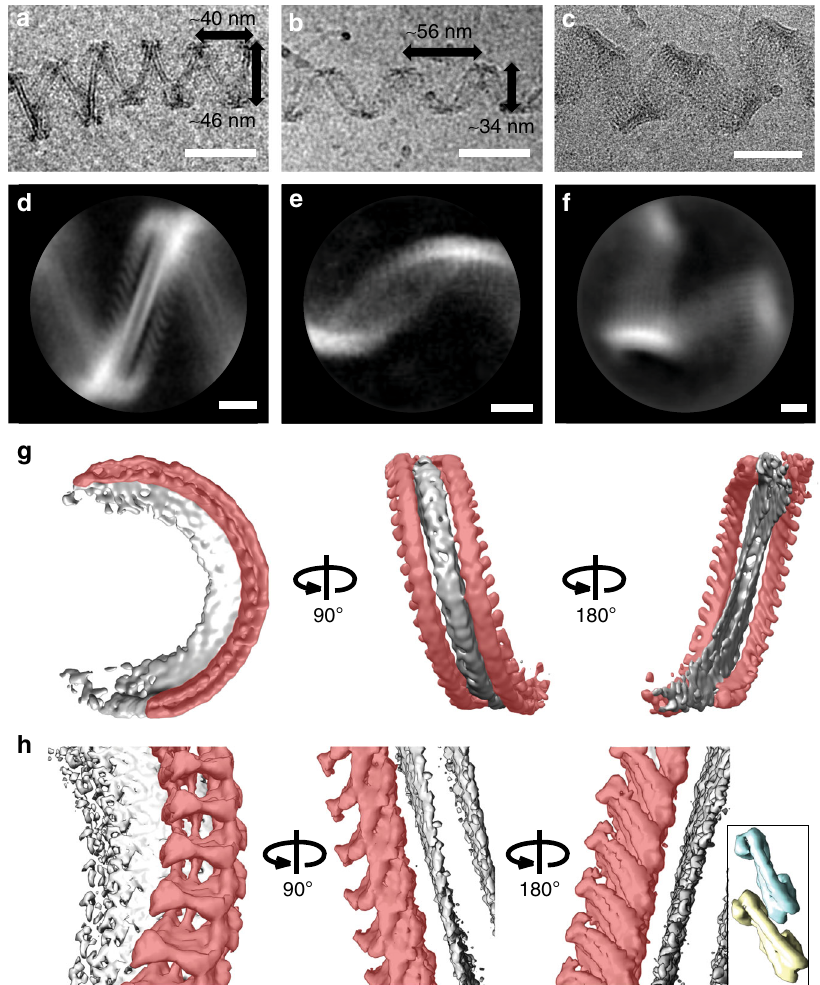
Fig. 3 Organization of tube-less ESCRT-III fi laments. Electron micrographs ( a – c , scale bars 50 nm) and 2D class averages ( d – f , scale bars 10 nm) showing different tube-less, helical ESCRT-III fi lament bundles formed from Snf7, Vps24, and Vps2 upon detergent removal. The majority of ribbons adopted a zigzag shape ( a , d ), others appeared sinusoidal ( b , e ) and a third set consisted of helical ribbons with higher strand numbers ( c , f ). The ribbon dimensions are rounded averages, for details see Supplementary Table 1. g Unmasked 3D average of a , d shows that the center of the ribbon is a helical bicelle with its plane perpendicular to the tube axis (grey). There are two anti-parallel double-stranded fi laments on both sides of the bicelle (red). h 3D average as in a , c with an asymmetric mask that included only one double-stranded fi lament (red). Inset: scale-matched densities corresponding to two closed- conformation IST1/CHMP8 subunits from EMD-6461 6 are shown for comparison. Source data are provided as a Source Data fi